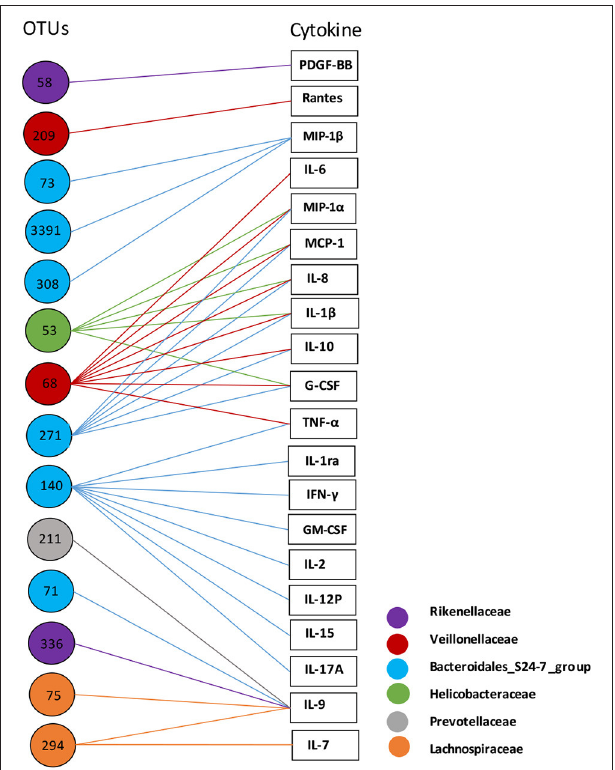
cytokines. Spearman rank correlation was performed. Only correlations with a coefficient r > 0.40 are displayed. The colors of OTU nodes and lines indicate bacterial families as labeled on the lower right.